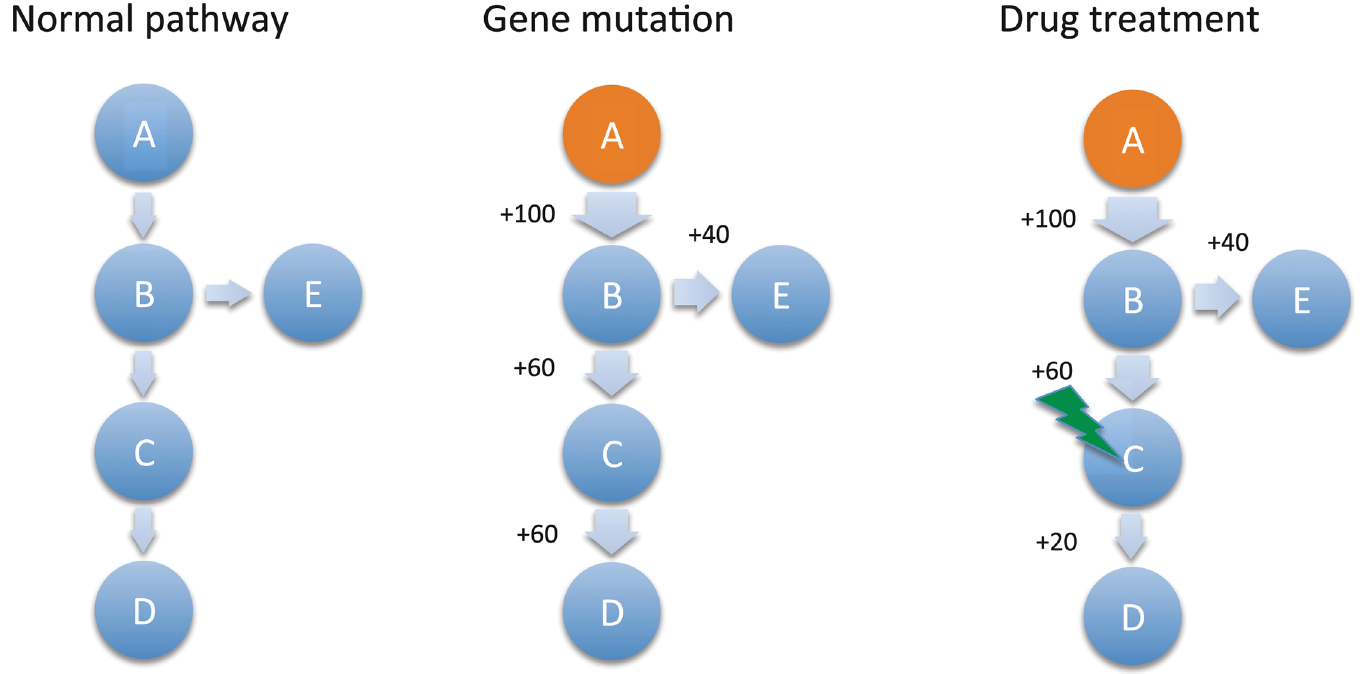
Fig 1. The overall workflow of our algorithm. Left panel lists the mutation status and activity flow of a normal pathway, where width of an edge represents activity flowing from the starting to the ending nodes. If gene A in the pathway mutated (marked as red), we suppose that this will increase the downstream pathway activity by 100, then the increased activity will flow to B, C, D and the terminal nodes eventually. If there are multiple paths from B, each path will share a certain proportion of the increased activity flowing to B. If an inhibitor for gene C is introduced to treat this sample, a certain proportion of increased pathway activity flowing through C will be inhibited. For example, only +20 activity is left after drug treatment.